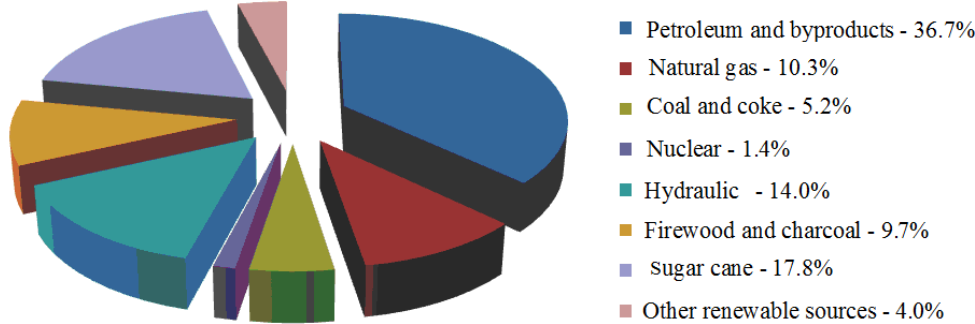
Figure 1. Primary energy production in Brazil in 2010